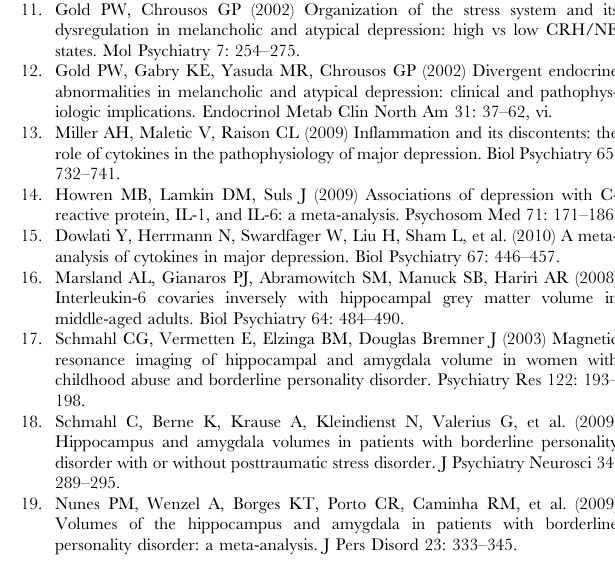
tension item sorted by